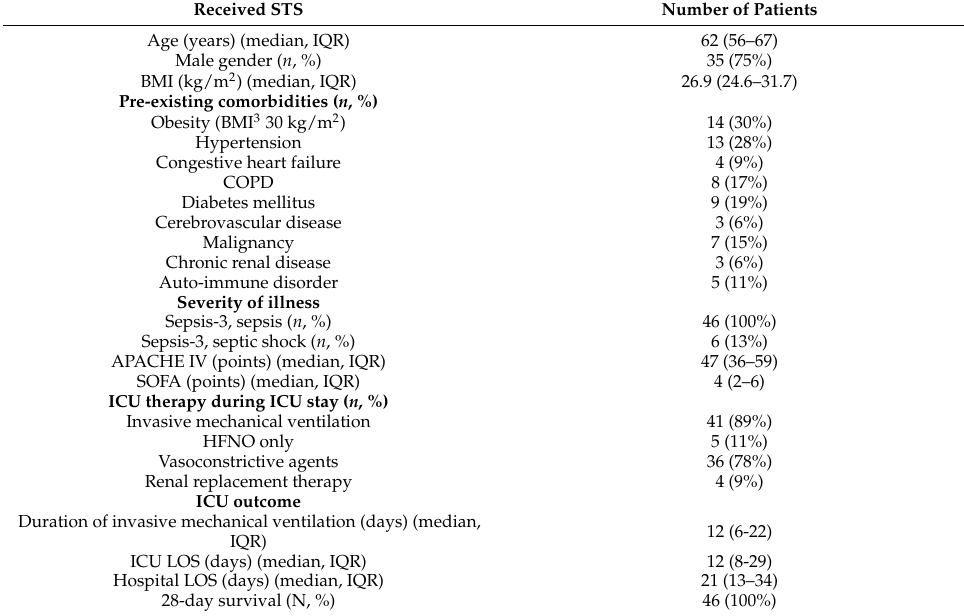
Table 1. Baseline characteristics of the patients with COVID-19 pneumonia.